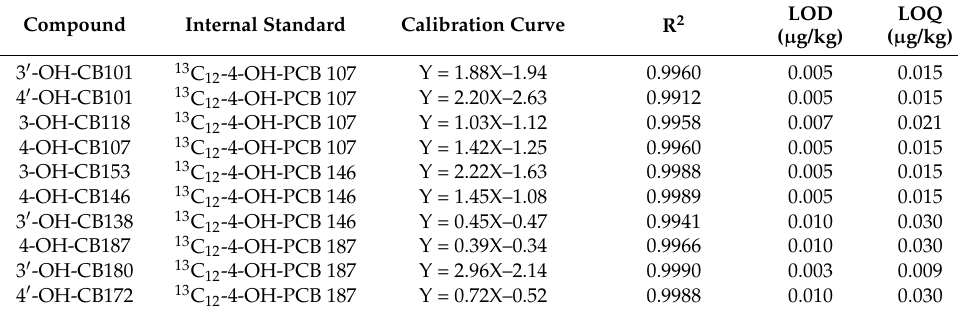
Table 1. Analytical performance